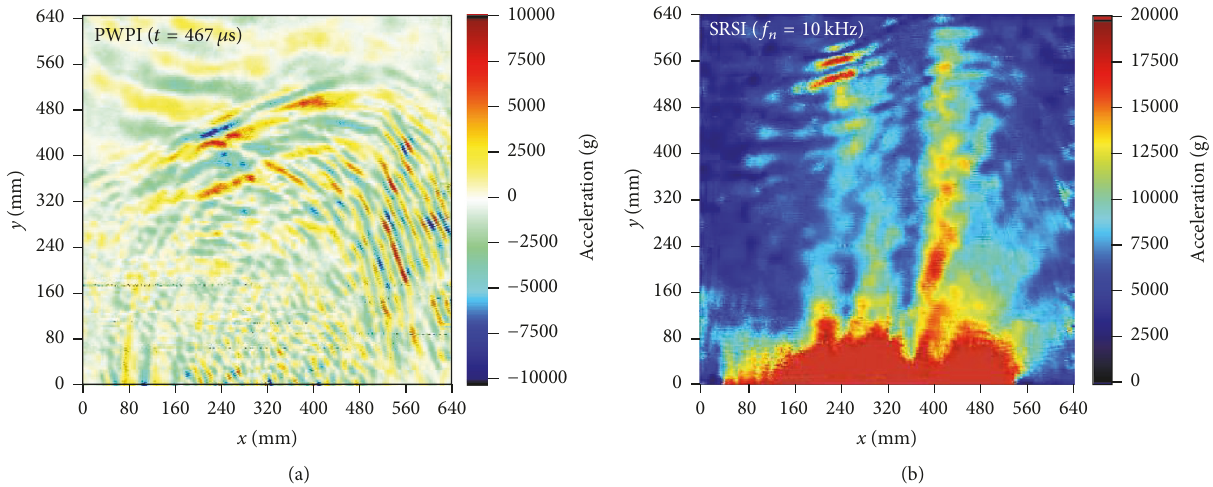
Figure 15: Linear explosive induced pyroshock propagation evaluation; (a) PWPI at 467 𝜇 s; (b) SRSI at 10kHz.